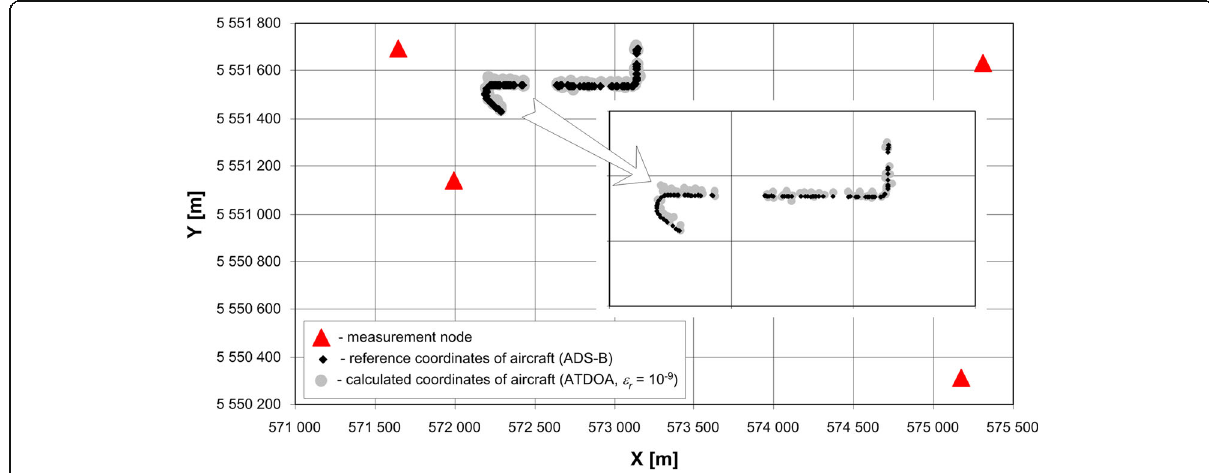
Fig. 9 Illustration of the considered case for testing the asynchronous